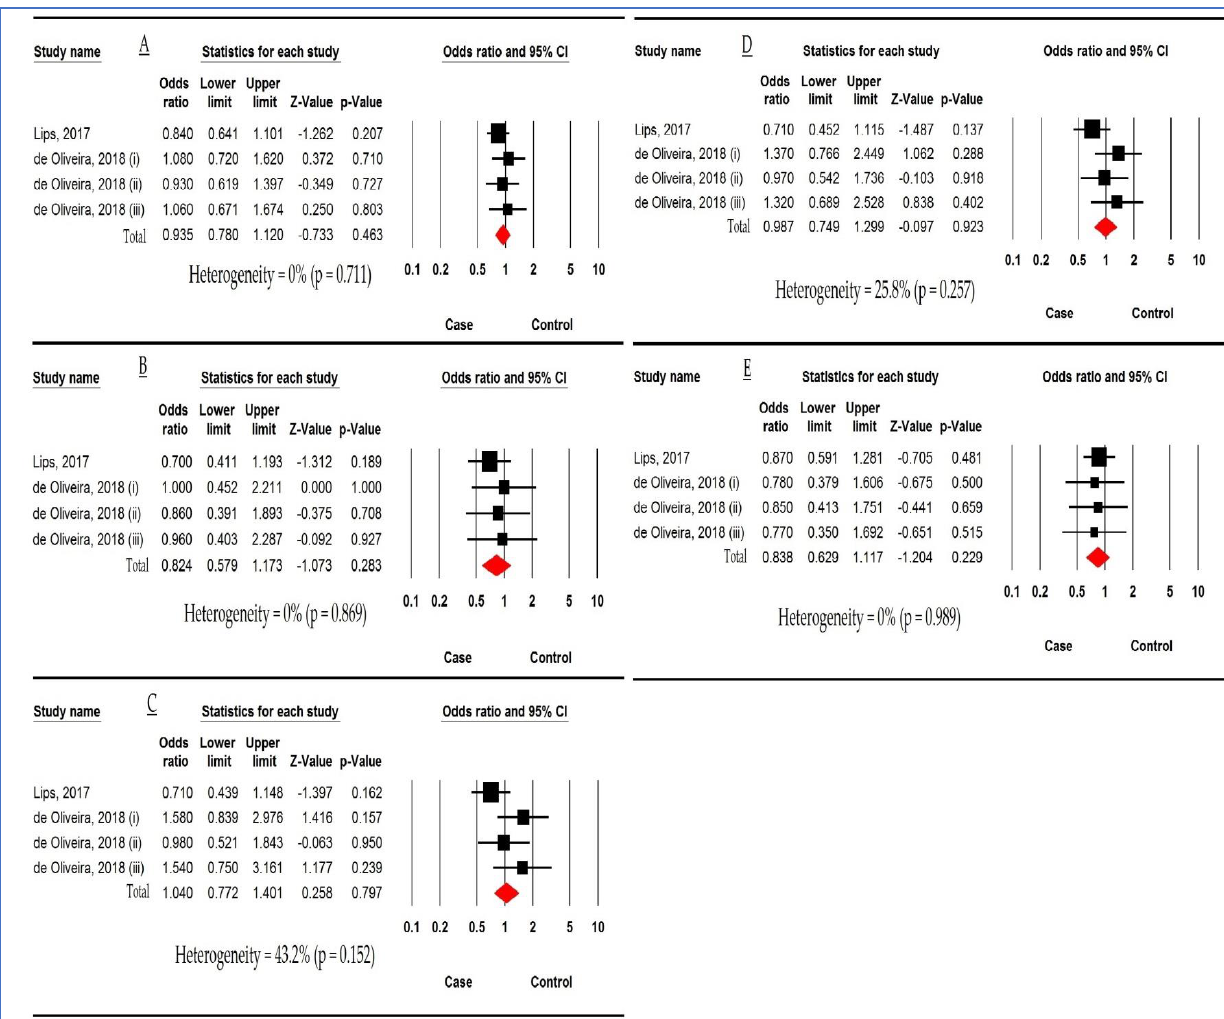
Figure 3. Forest plot analyses demonstrating the relationship between defensin beta 1 (DEFB1) rs1799946 polymorphism and dental caries risk. A ) Allelic model. B ) Homozygous model. C ) Heterozygous model. D ) Dominant model. E ) Reces- sive model. ((i) Deciduous dentition. (ii) Permanent dentition. (iii) Mixed dentition in the study of de Oliveira et al.